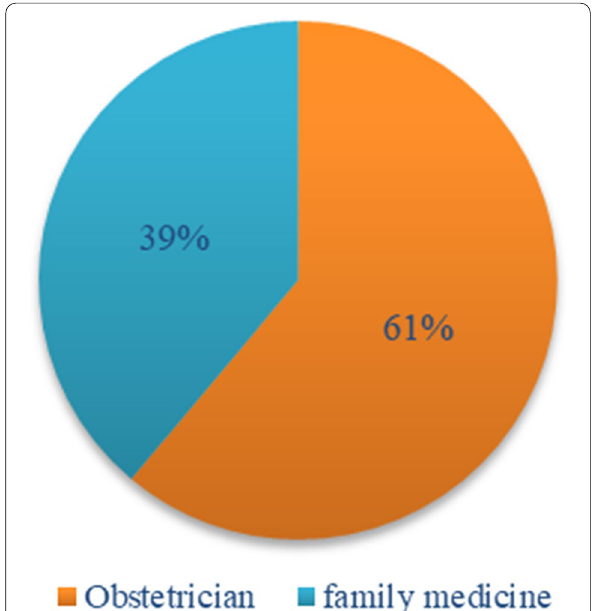
Fig. 1 Distribution of the participants according to